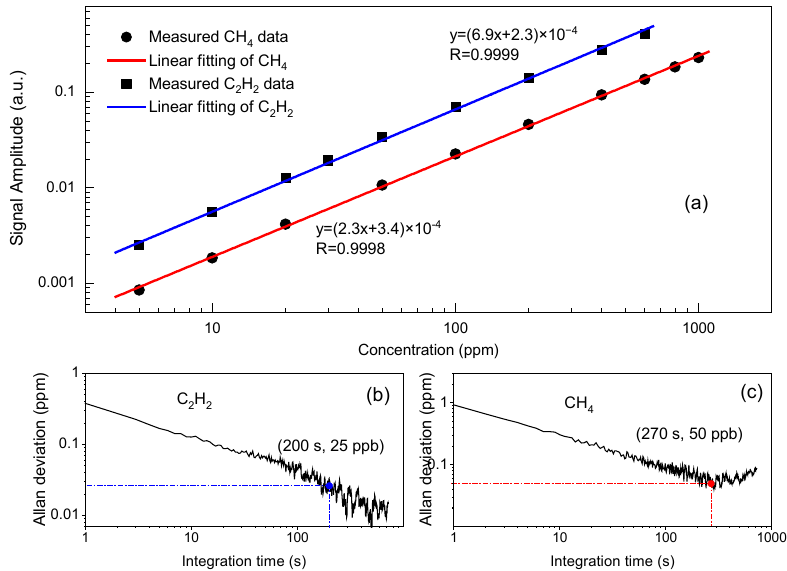
Figure 9. ( a ) Signal amplitude as a function of sample gas concentration; Allan deviation analysis as a function of integration time for ( b ) C 2 H 2 and ( c ) CH 4 . The sensor shows a good linear response for both C 2 H 2 and CH 4 . The MDLs at 1 s are 0.4 ppm and 1 ppm for C 2 H 2 and CH 4 respectively. An MDL of 25 ppb for C 2 H 2 at 200 s and 50 ppb for CH 4 at 270 s can be obtained.